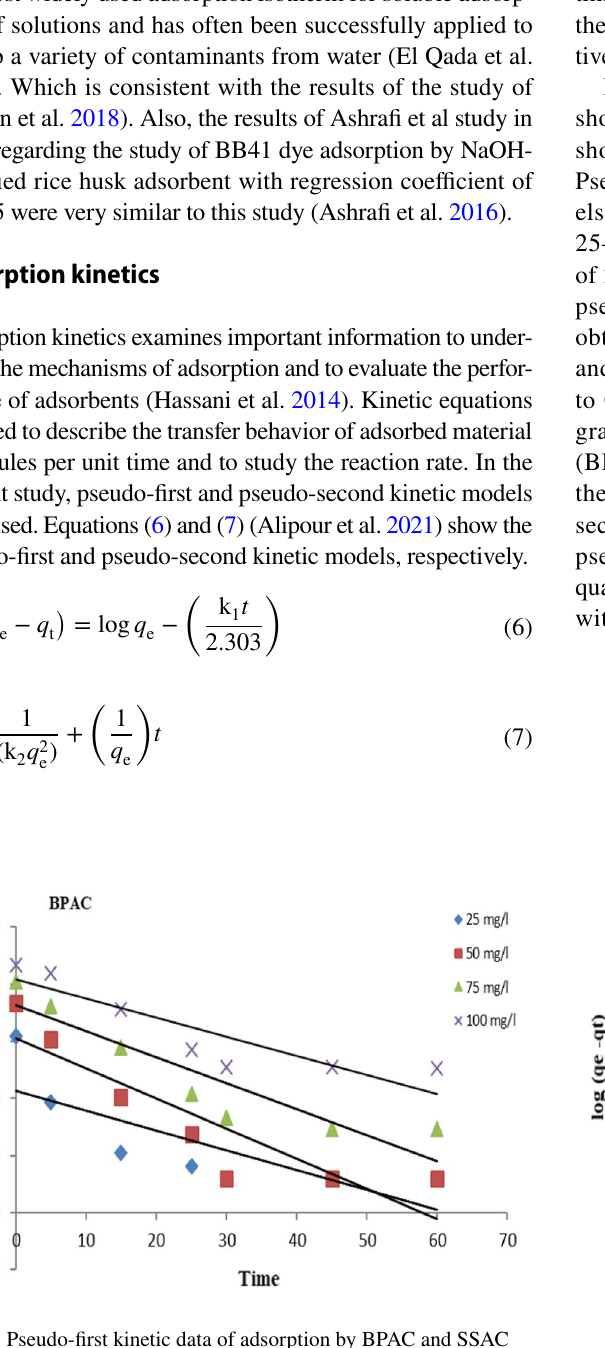
Fig. 10 Pseudo-first kinetic data of adsorption by BPAC and